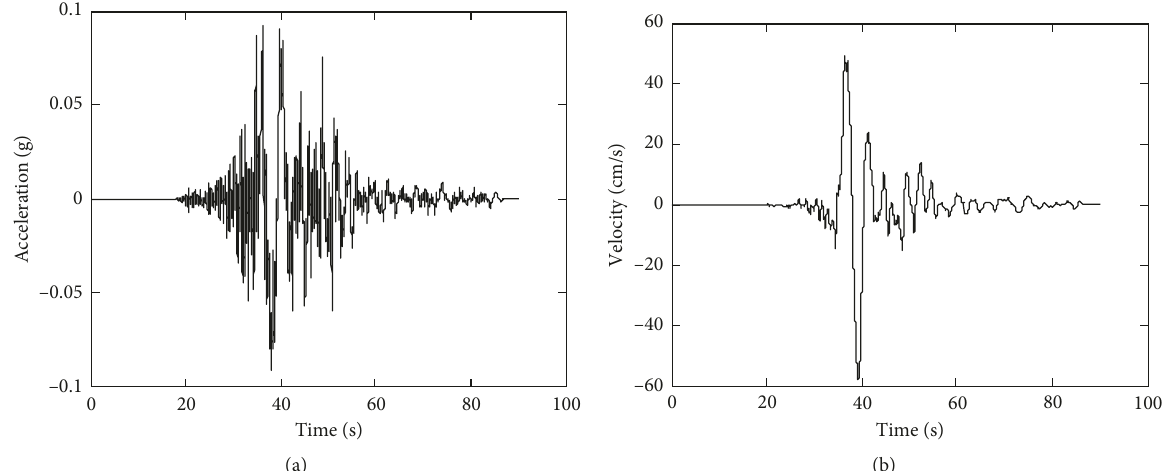
Figure 1: Time history of RSN1519 Chi-Chi Taiwan: (a) acceleration; (b)